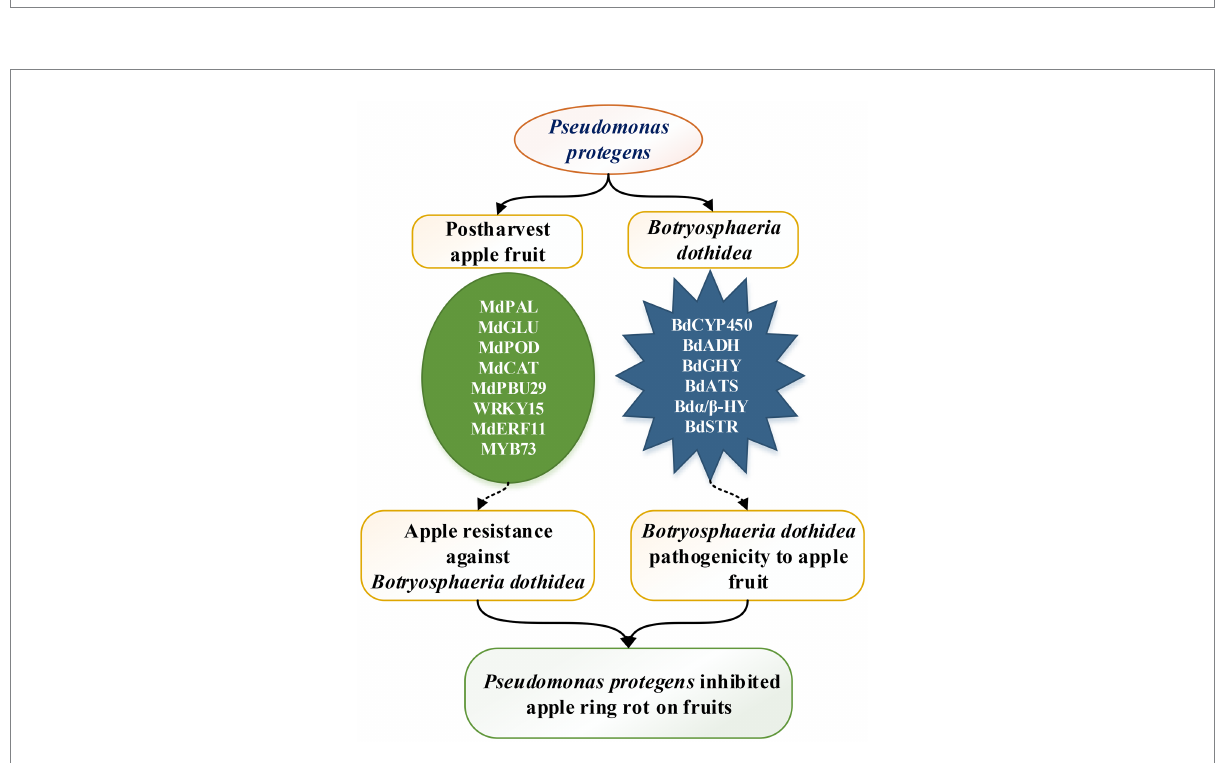
FIGURE 8 The model of P. protegens inhibiting the apple ring rot on fruit caused by B. dothidea